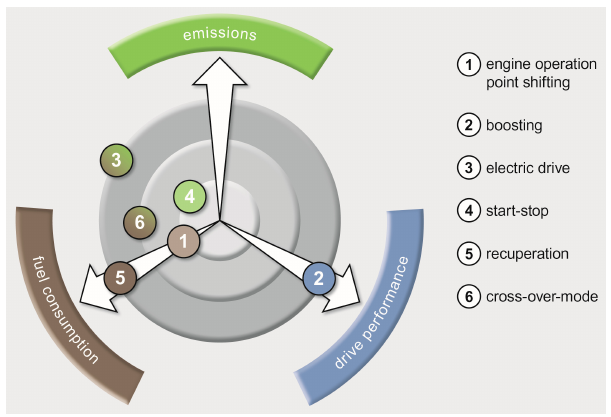
Figure 1. Overview of hybrid powertrain functionalities.